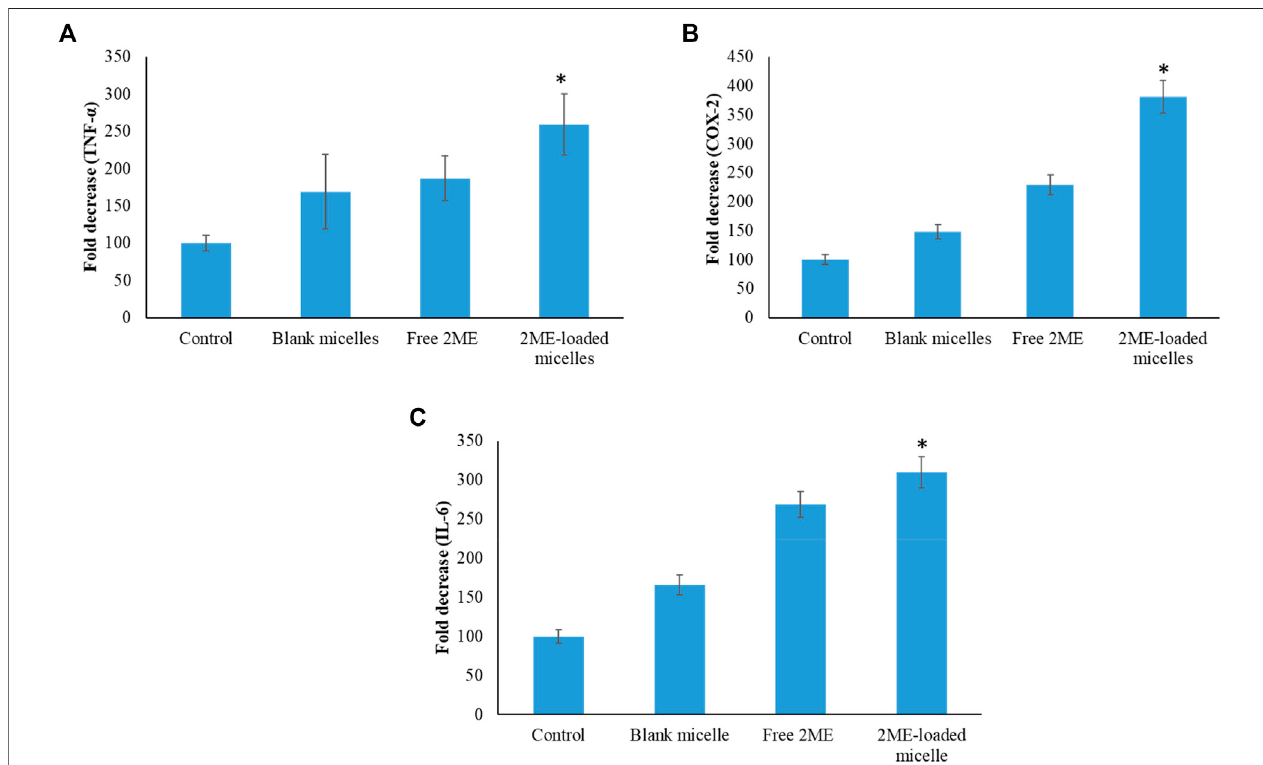
FIGURE10| ChangeintheexpressionlevelsofTNF- α (A) ,COX-2 (B) ,andIL-6 (C) onthePC-3cellsfollowingincubationwithblankmicelles,free-2MEand2ME- loadedmicelles,and vehiclecontrolcells. * representssigni fi cantdifference between 2ME-loaded micelles vsother formulationsgroup ( p < 0.05).Values are expressed as mean ± SD ( n (cid:2)